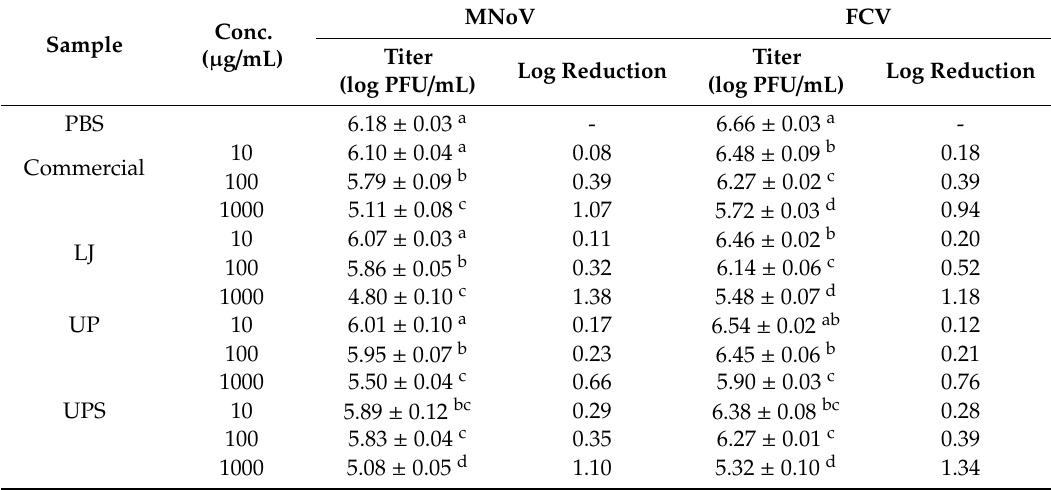
Table 1. Inhibitory e ff ects of the fucoidans from Laminaria japonica (LJ), Undaria pinnatifida (UP) and Undaria pinnatifida sporophyll (UPS) against murine norovirus (MNoV) and feline calicivirus (FCV).